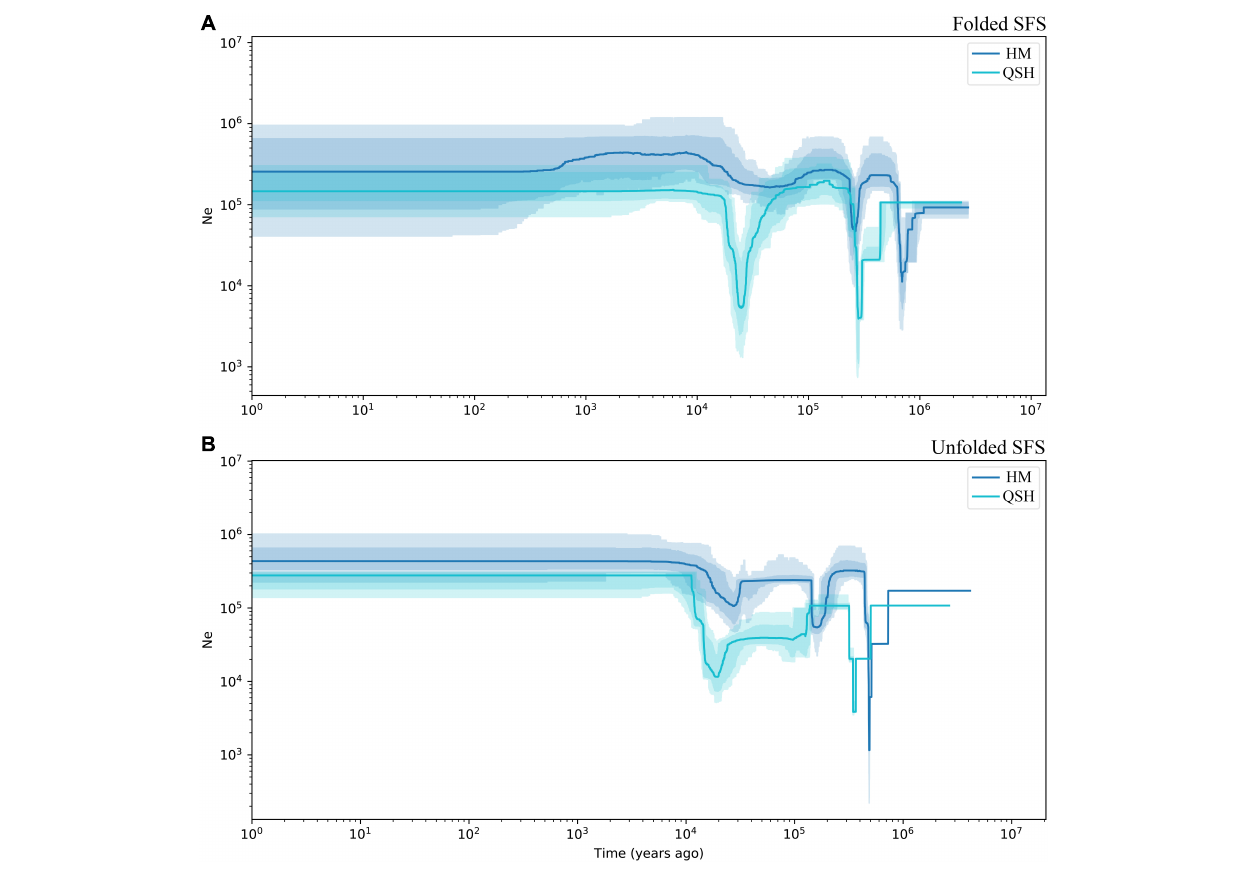
FIGURE 4 | Demographic history of Magnolia fistulosa inferred by Stairway plot2. HM and QSH were inferenced with (A) folded SFS and (B) unfolded SFS. The 95% confidence interval for the estimated effective population size is shown by light